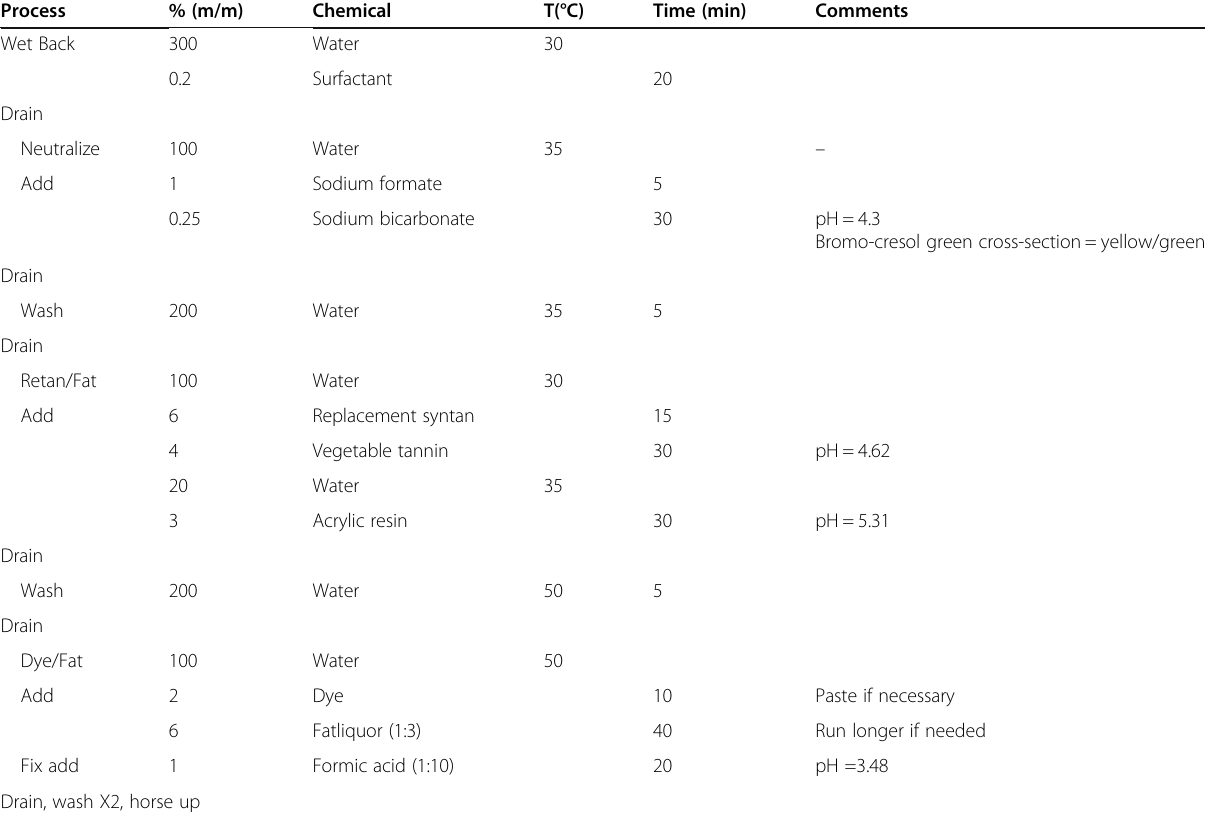
Table 1 Fatliquoring Process for Shoe Upper Leather Manufacture